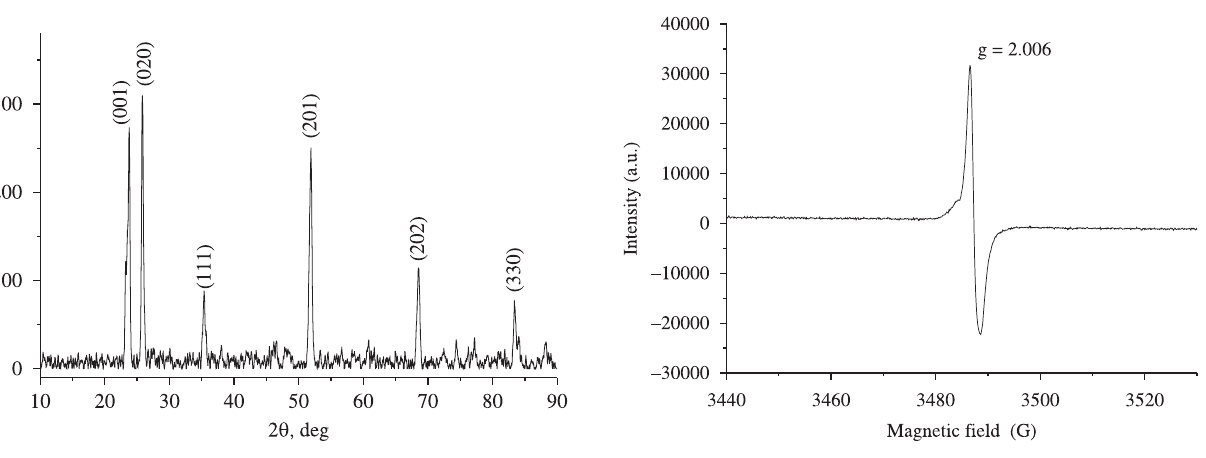
Figure 3. Role of the solvents on NTCDA-Al(0)/OH – reaction.